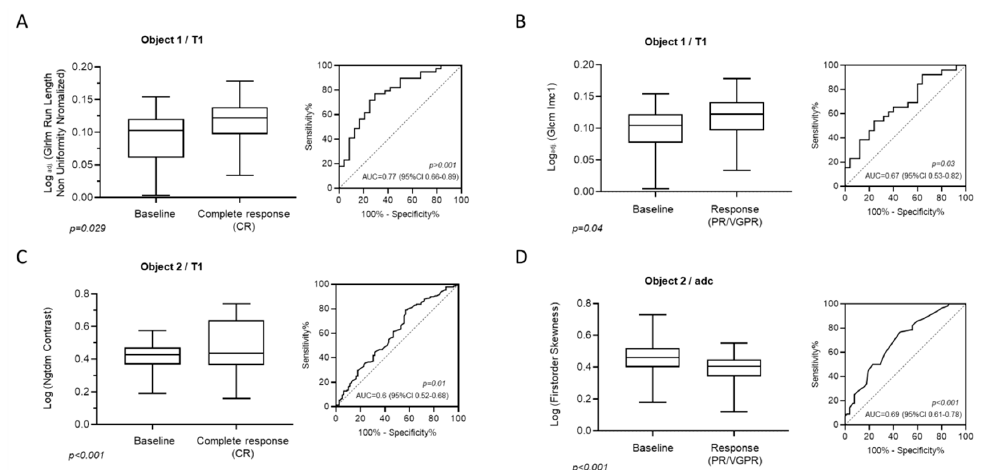
Figure 4. Box plots presenting the statistically significant textural features on T1-weighted images both in focal ( A/B ) and diffuse marrow involvement ( C/D ) both for patients experiencing complete response ( A/C ) and very good partial response/partial response ( B/D ). The ROC analysis on the right illustrates the AUC, corresponding p -value and confidence interval for the log of the analyzed texture feature.